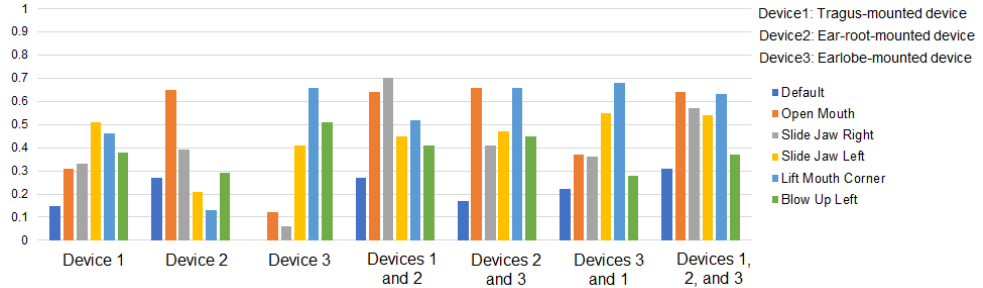
Figure 14. The results of each gesture in Evaluation 3 testing with leave-one-user-out. The average F-value for each device